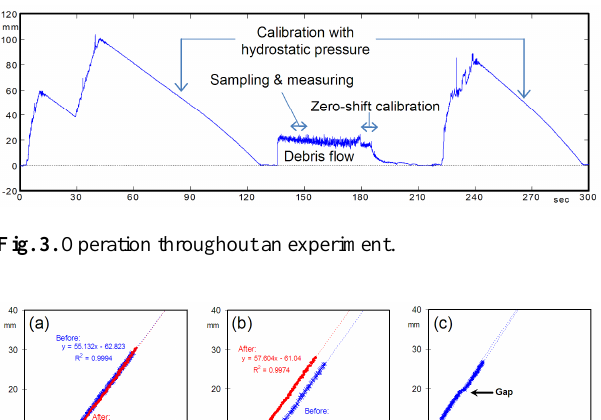
Fig. 3 Operation throughout an experiment. Fig. 4. Examples of (a) successful sensor calibration, and calibra- tion failures due to (b) a difference in the pre- and post-experiment offset and (c) a sensitivity gap (non-linearity) during the calibration.